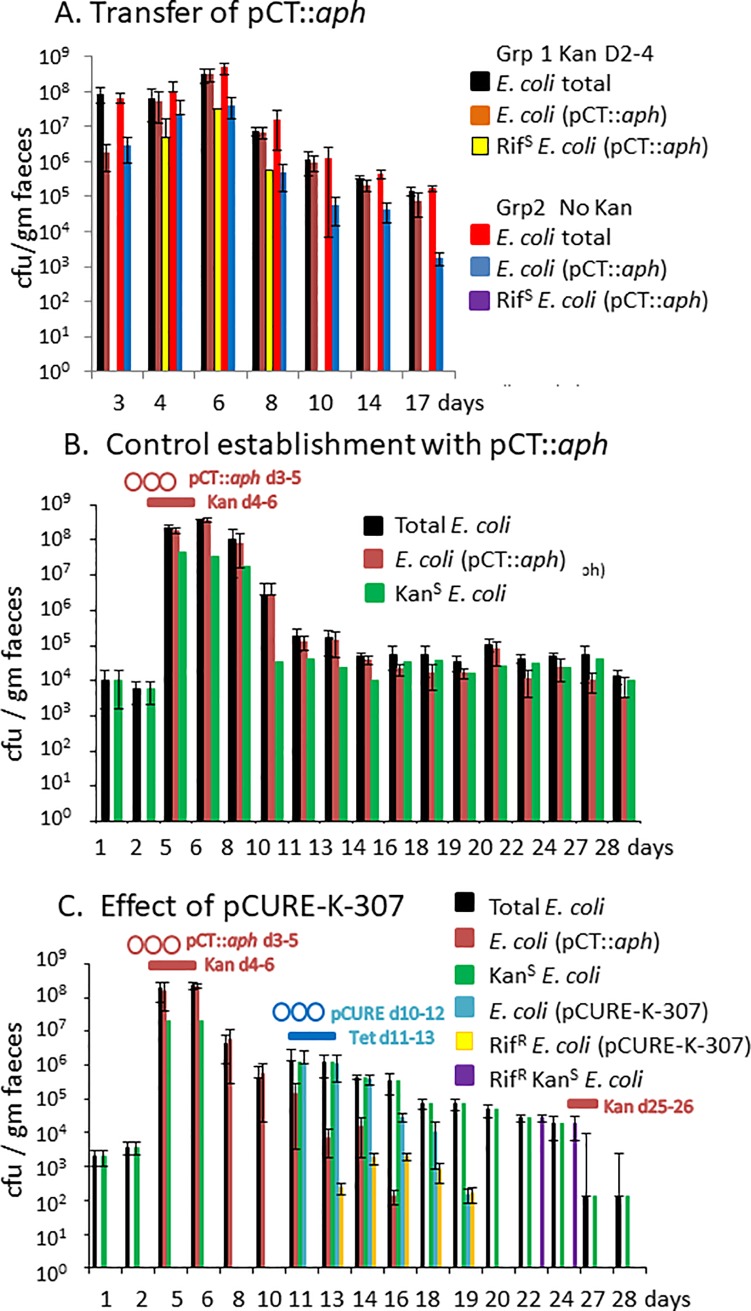
Testing ability of pCURE-F-307 to displace antibiotic resistance plasmids in the mouse gut.A. RifR mouse-derived E. coli AL1 carrying pCT::aph was fed to six mice days 1–3. Three mice (group 1) also received kanamycin days 2–4. Plasmid transfer to endogenous RifS
E. coli was only observed in group 1. The data for this experiment is shown in the Tables in S3 Text. B. Baseline total endogenous KanSTetS
E. coli were detected before introduction of E. coli AL1 (pCT::aph) days 3–5 and kanamycin days 4–6 before monitoring plasmid carriage until day 28. RifS
E. coli cfu were determined by subtracting RifR cfu from total E.coli cfu. The data for this experiment is shown in the Tables in S4 Text. C. Mice treated as in B received E. coli Nissle 1917 carrying TetR curing plasmid, pCURE-K-307 days 10–12 and tetracycline days 11–13 resulting in the appearance of TetR
E. coli including RifR TetR indicating transfer to target bacteria. pCURE-K-307 had disappeared by day 20 but about 10% of the E. coli were RifR indicating displacement of pCT::aph rather than loss of the strain. Kanamycin was given days 25–26 but no KanR bacteria re-appeared and PCR screening of faeces samples at the end of the experiment proved negative. Carriage of pCT::aph was determined by KanR while carriage of pCURE-K-307 was determined by TetR. The data for this experiment is shown in the Tables in S4 Text.